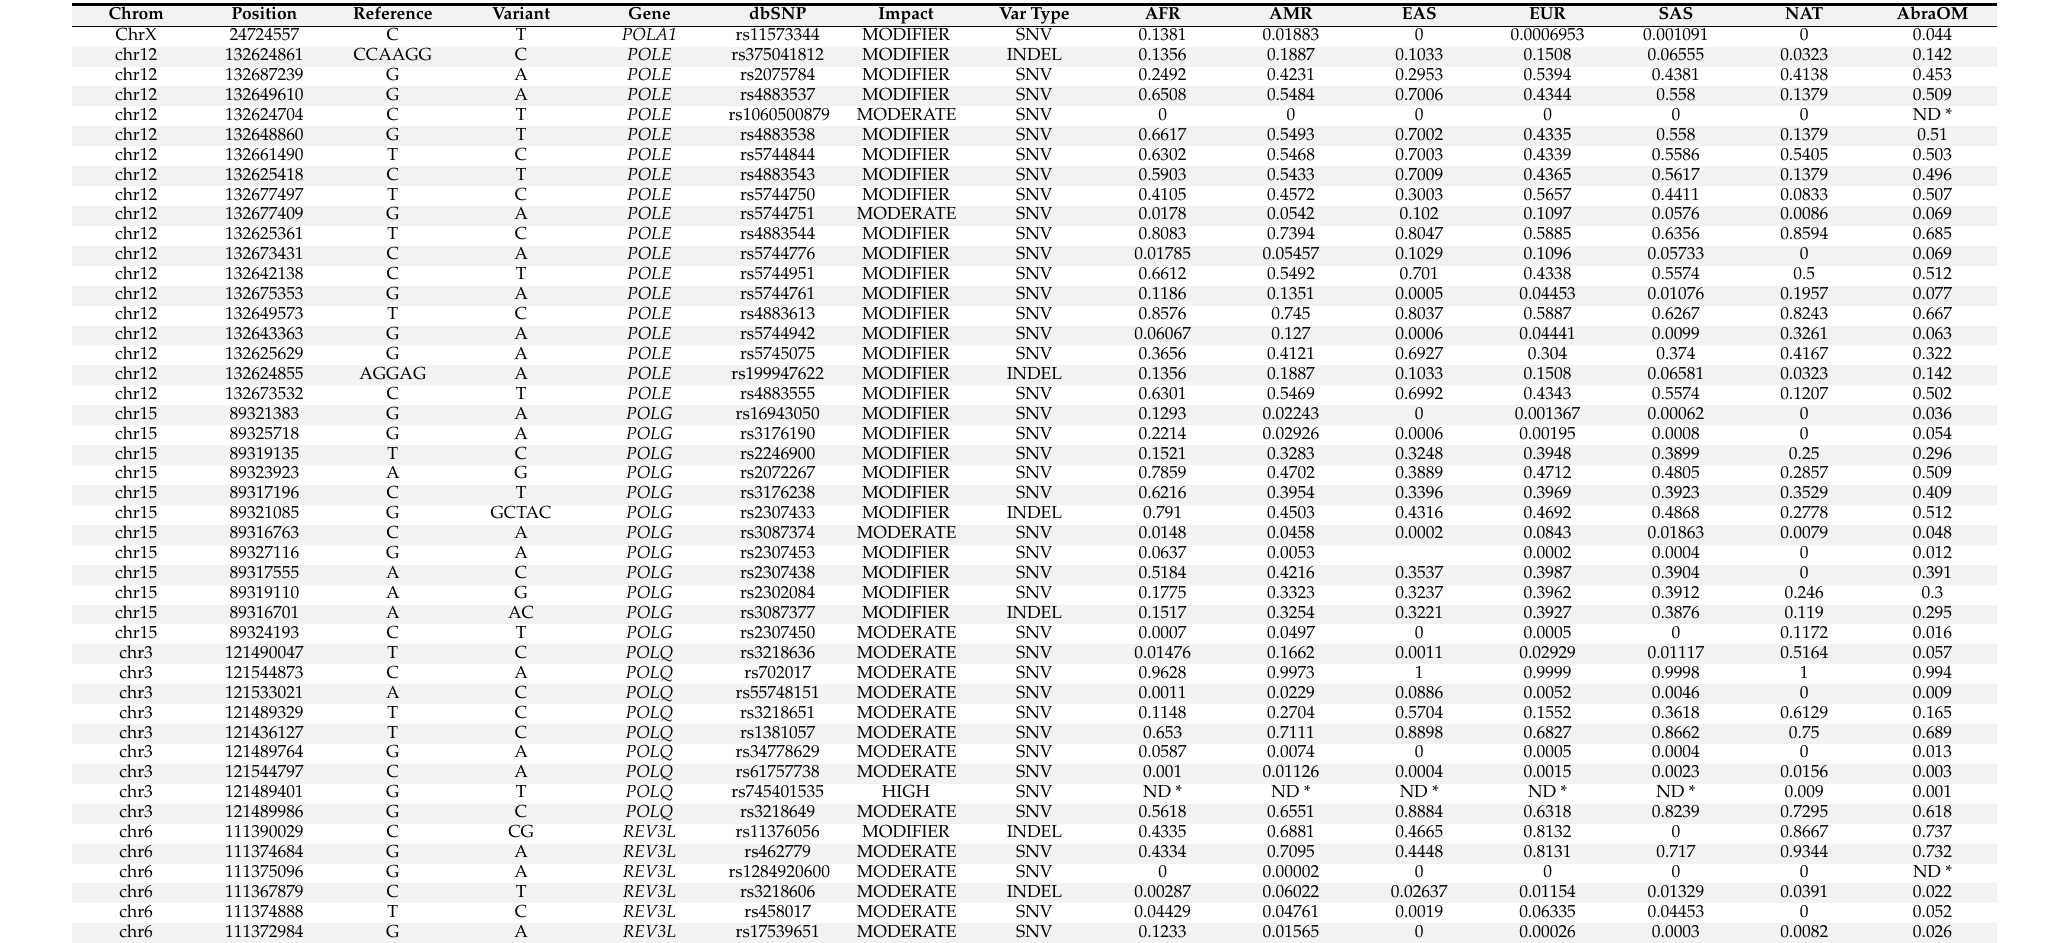
Table 1. Allele frequencies of the variants investigated in the Indigenous population (NAT), in the Brazilian population of Sao Paulo (ABraOM) and in African (AFR), European (EUR), American (AMR), East Asian (EAS) and South Asian (SAS) from the gnomAD